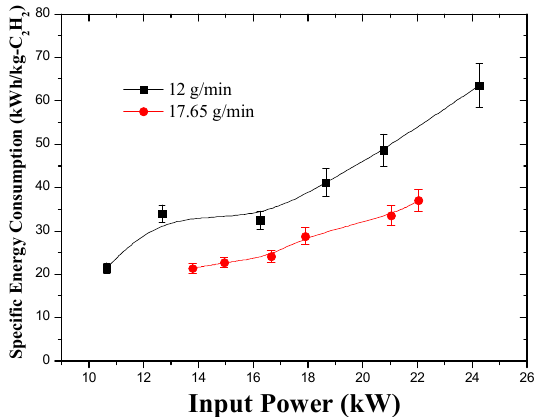
Figure 6. Effects of input power on the specific energy consumption ( SEC ) of C 2 H 2 at feed rate of 12 g/min and 17.65 g/min (Carrier gas flow rate: 1 Nm 3 /h; working gas flow rate: 5 Nm 3 /h; magnetic flux intensity: 0.077 T).